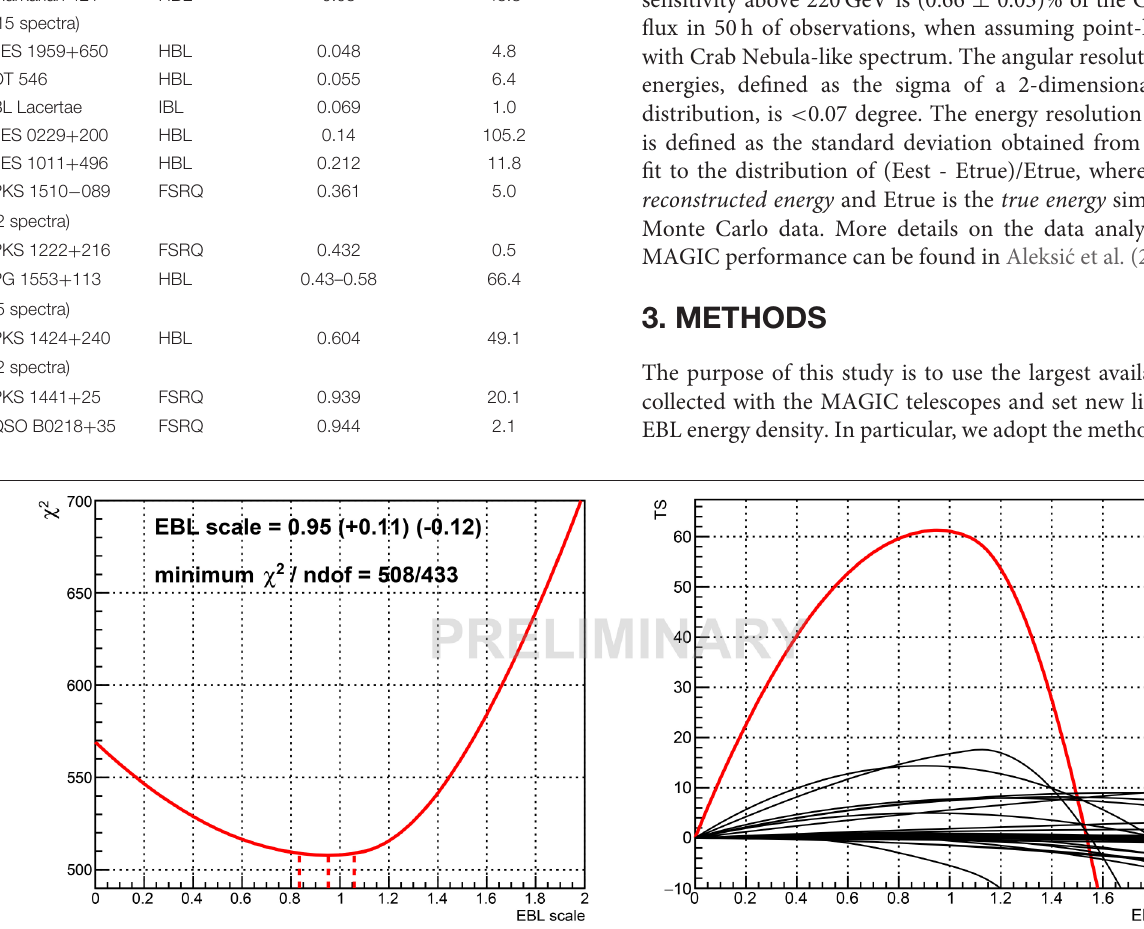
FIGURE 1 | Left: Total χ 2 from the maximum likelihood fit. Right: Total (red) and spectrum-wise (black) Test Statistics TS = χ 2 (0) − χ 2 vs. EBL scale relative to the Domínguez